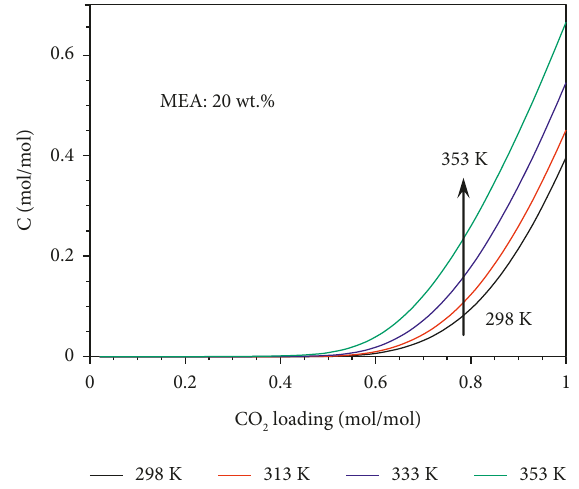
Figure 8: Bulk CO 2 concentrations at different temperatures as a function of CO 2